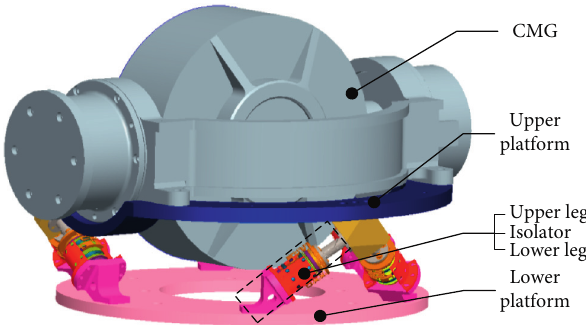
Figure 1: The 3D model of microvibration suppression